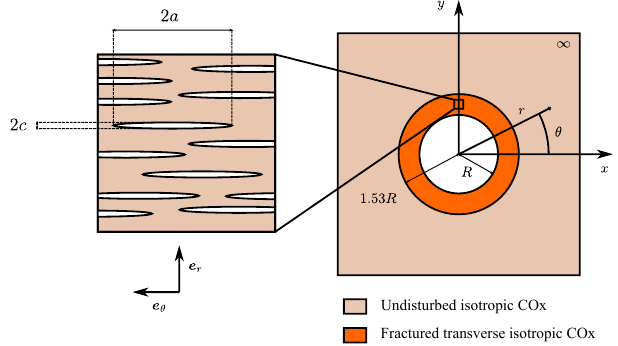
Figure 1. Geometrical representation of the model of the CDZ ex- periment.